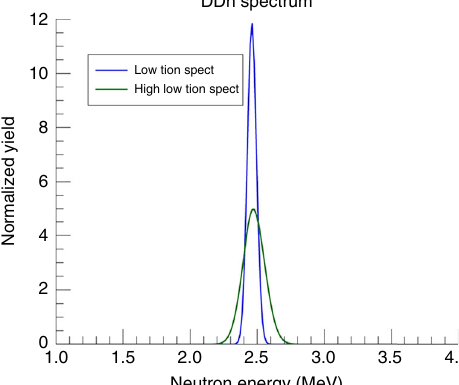
Fig. 6 Distinctive neutron spectra help assess plasma conditions. D(d,n) 3 He reaction neutron energy spectra from single-temperature plasma (blue) and two-temperature ion distribution